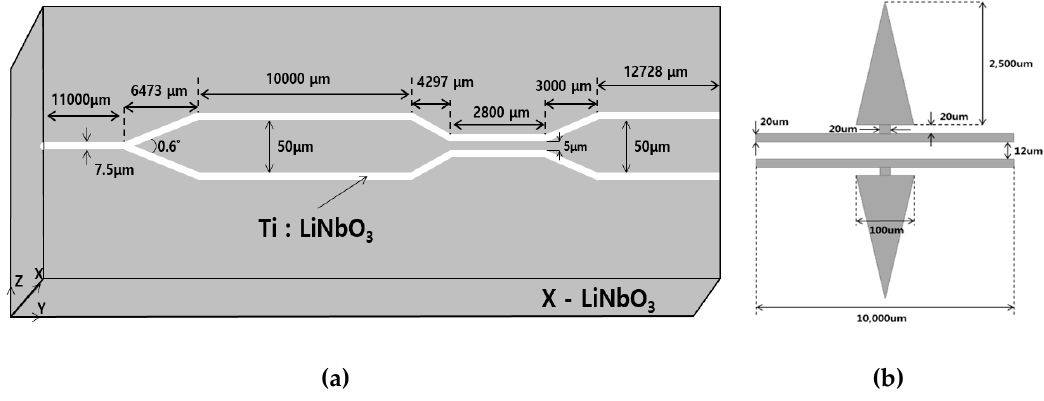
Figure 1. Schematic diagrams and dimensions of ( a ) a Ti: LiNbO 3 1 × 2 Y-fed balanced-bridge Mach–Zehnder interferometer (YBB-MZI) modulator and ( b ) a dipole patch antenna.